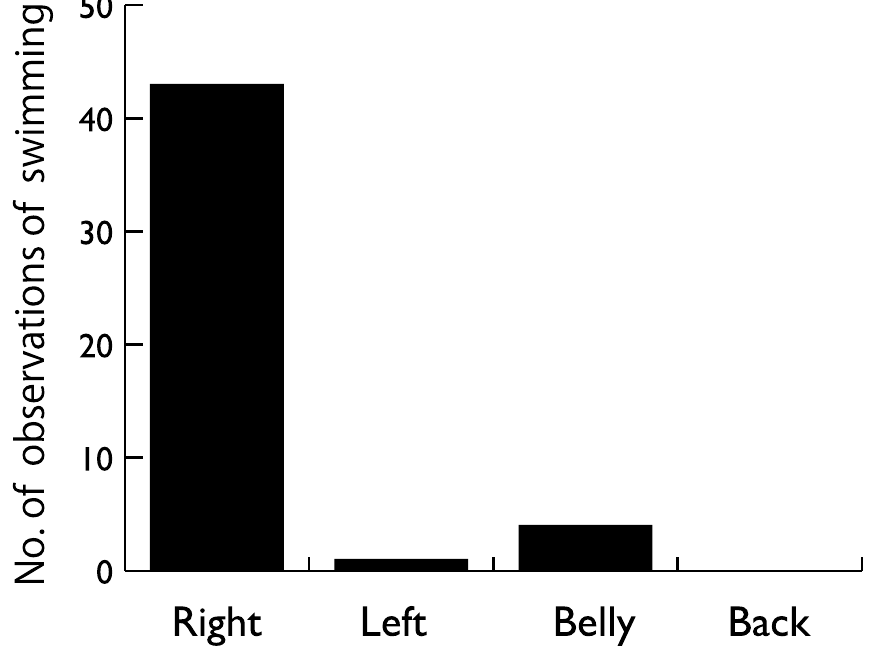
Figure 4. Distribution of postures of finless porpoises in straight swimming before the sharp turn to catch the prey: on the right side (right), on the left side (left), on the belly (belly), and on the back